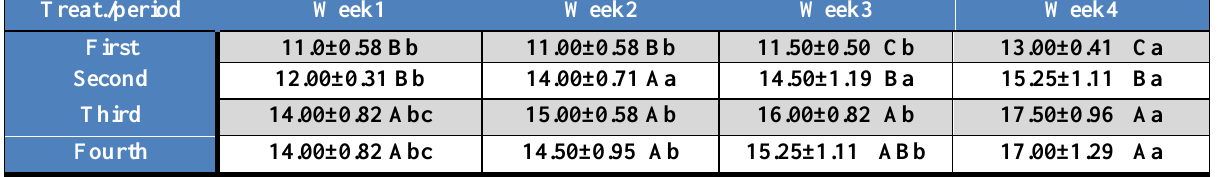
Different small letters showed significant difference among periods at the level of (P < 0.05). Different capital letters showed significant difference among treatments at the level of (P < 0.05). Table, 3: Effect of Vit. C and/or Vit.B on the Hb (gm/dl) of rabbits (Mean ± SE). Treat./period